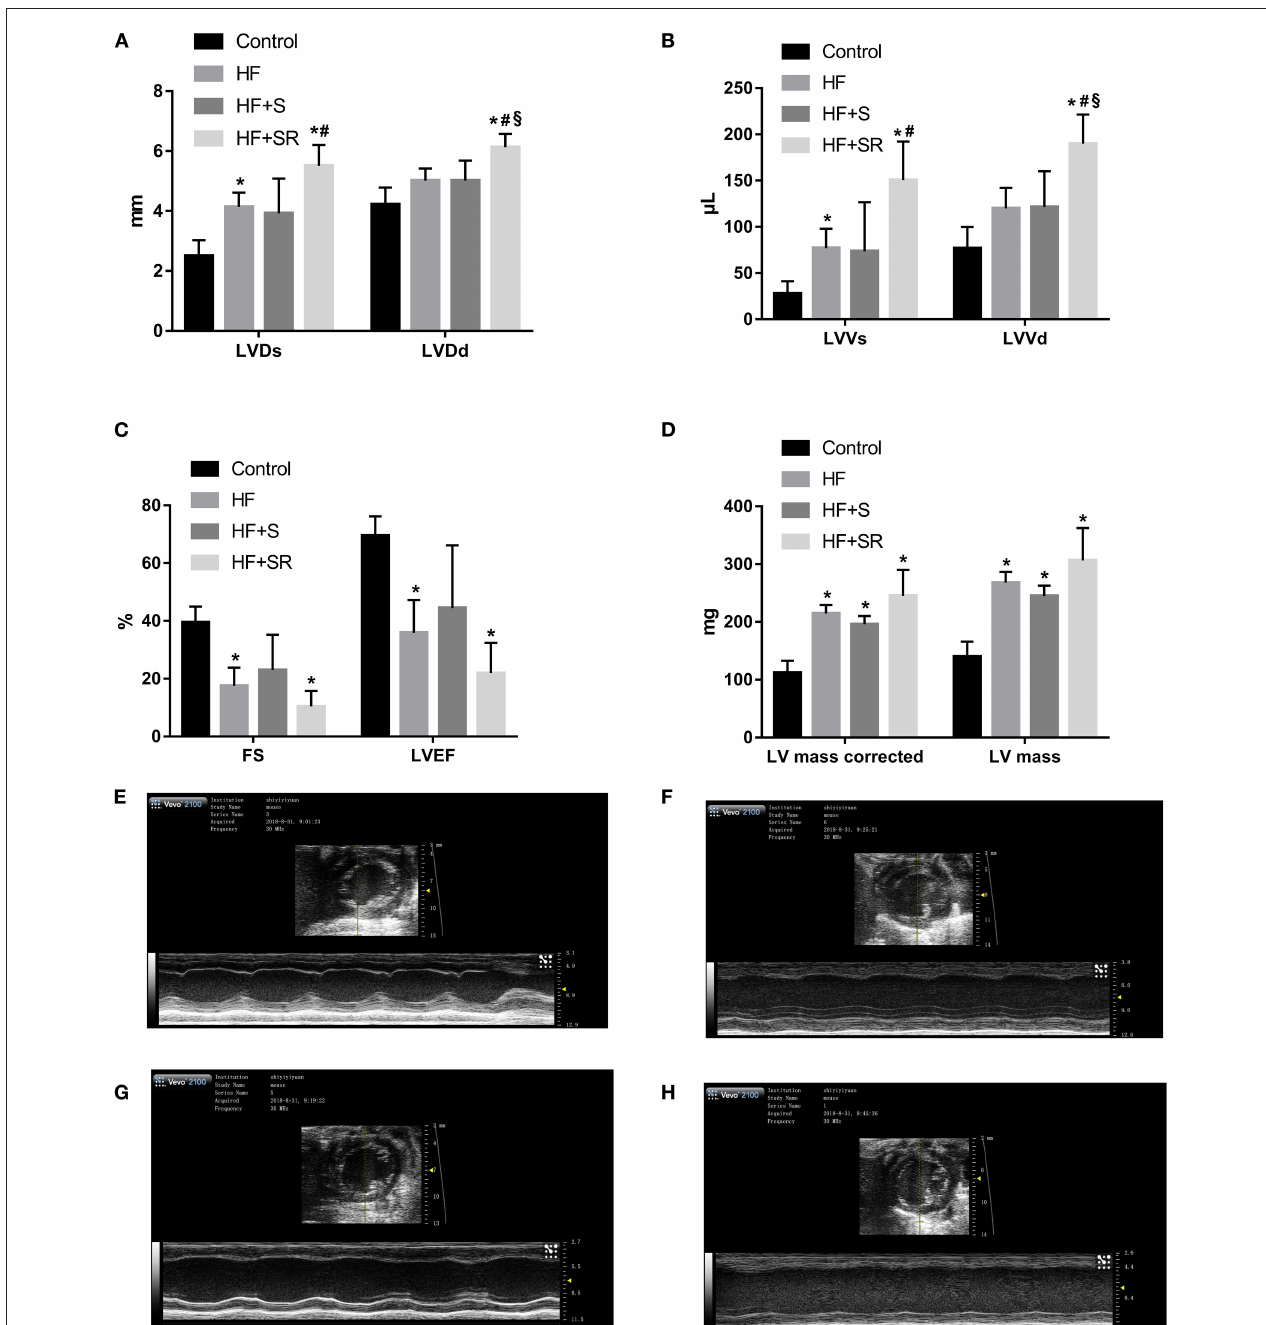
FIGURE 3 | Comparison of echocardiographic parameters among the different groups at 56 days after administration. Comparisons of LVDs, LVDd (A) , LVVs, LVVd (B) , FS, LVEF (C) , LV mass and LV mass corrected (D) among the control ( n = 4), HF ( n = 5), HF + S ( n = 8), and HF + SR ( n = 8) mice. Representative echocardiographic images in the control (E) , HF (F) , HF + S (G) , and HF + SR (H) mice. * P < 0.05 vs. controls, # P < 0.05 vs. HF group, and § P < 0.05 vs. HF + S